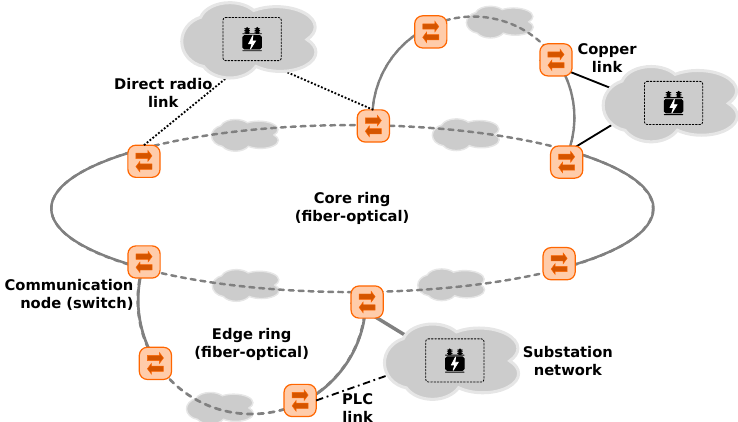
Figure 2. A schematic illustration of a typical ring-of-ring topology, consisting of a core ring and multiple edge rings connecting the field stations of remote grid areas. The rings are often based on fibre-optic technology, while the spoke links to field stations may use different layer-1